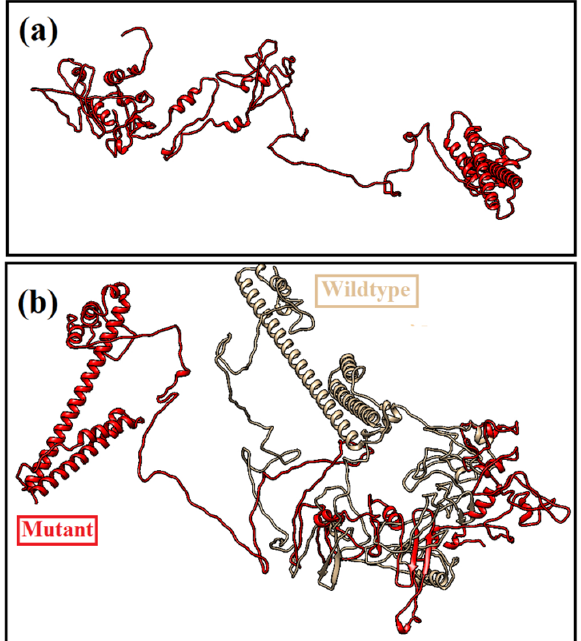
Figure 2. ( a ) Three-dimensional model of mutated (A82V + P337S) Ebola virus spike protein, and ( b ) superimposed structure of mutated and normal Ebola virus proteins.